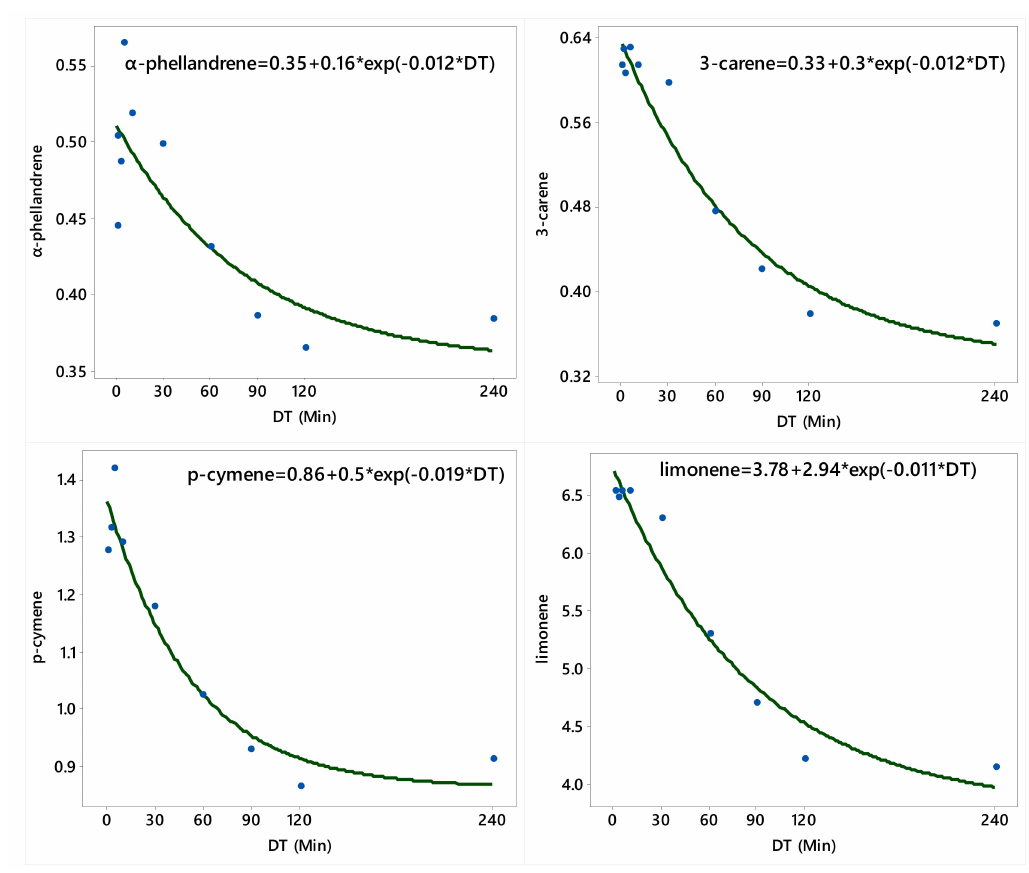
Figure 3. Plot of distillation time (DT) vs. the concentrations (%) of α -phellandrene, 3-carene, p -cymene, and limonene along with the fitted (solid line) asymptotic (convex) regression model. Table 3. Mean concentration (%) of γ -terpinene, terpinolene, terpinen-4-ol, safrole, and myristicin obtained from ten hydrodistillation timeframes (DT) and control (straight 240